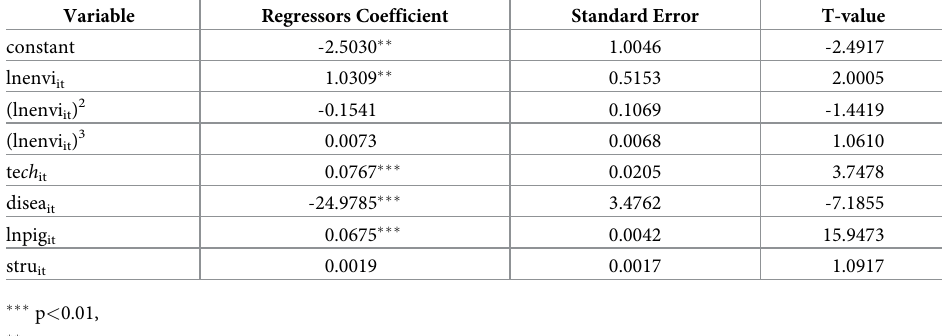
Table 12. The estimation results of influencing factors of cost inefficiency model for